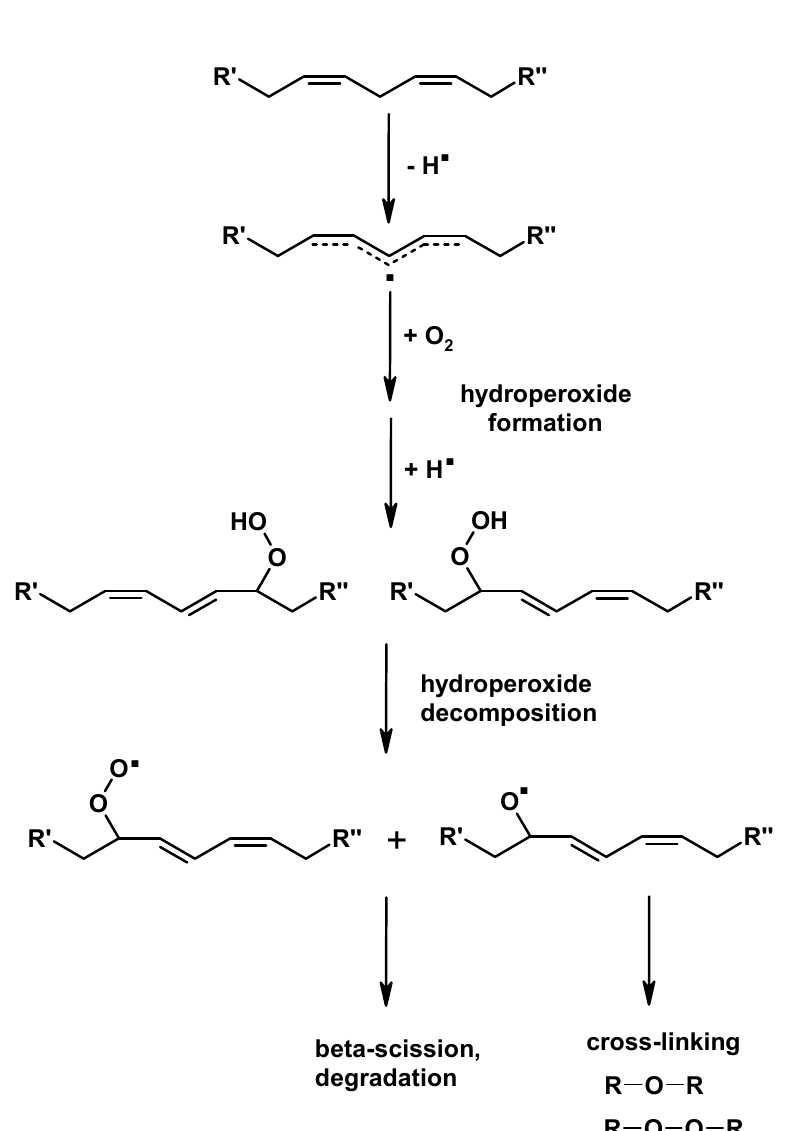
Figure 2. Simplified scheme of mechanisms of alkyd curing via Oxidative Catalysis and O 2 .